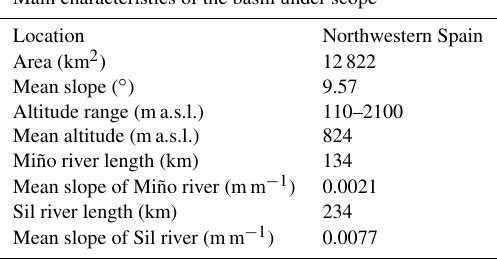
Table 1. Main characteristics of the basin under scope (Miño–Sil basin to Ourense city), including the Miño river and its main tribu- tary, the Sil